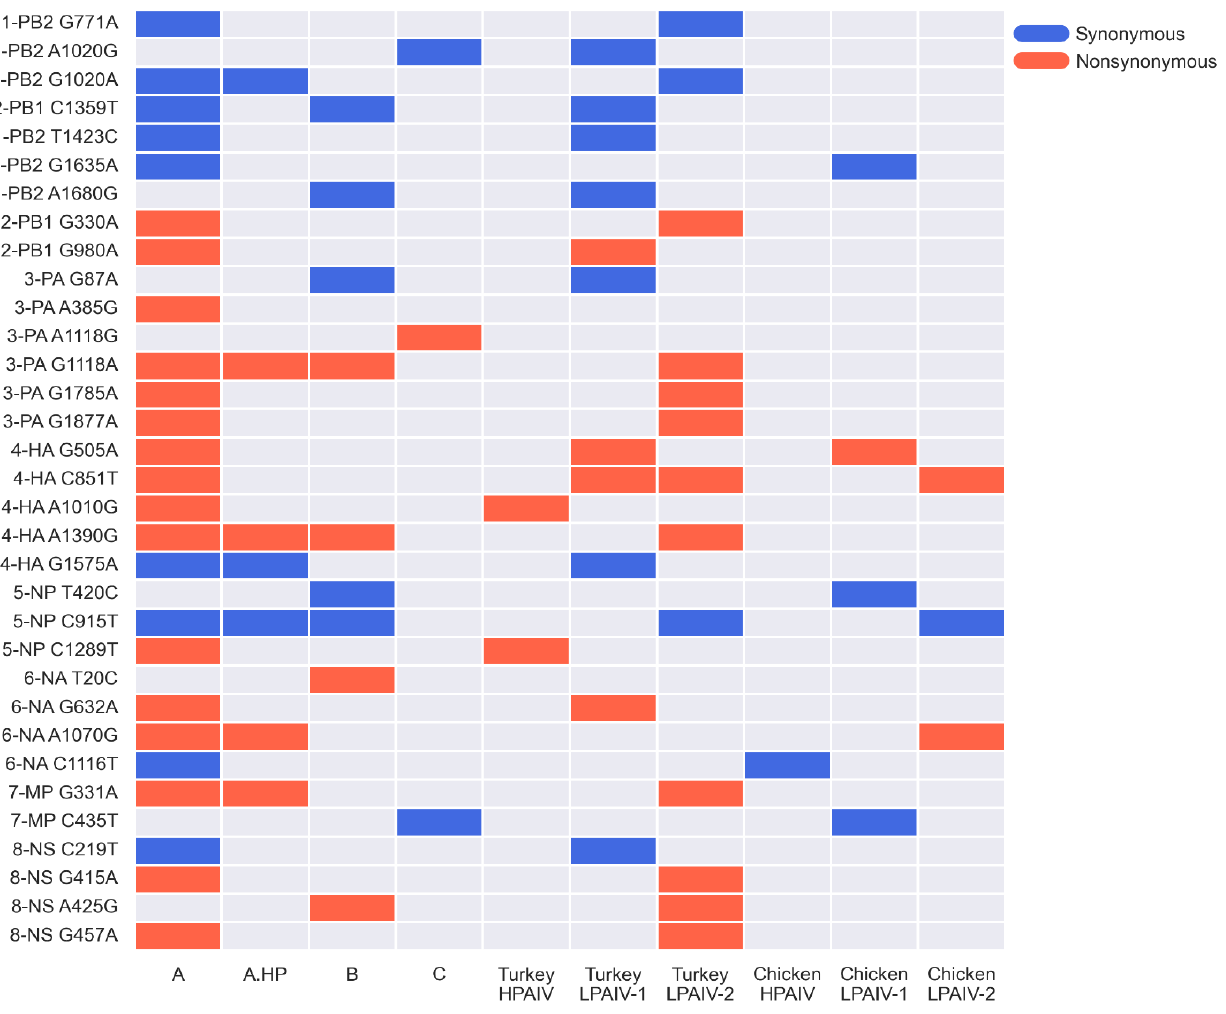
Figure 7. Matrix of common SNVs found in iSNVs, and pairwise comparisons of all H7N3 viruses sequenced from the 2020 US outbreak. The iSNVs identified in samples from experimentally infected turkeys and chickens were compared against the single nucleotide changes that were found in all possible pairwise comparisons among all twenty-nine virus isolates during the 2020 US H7N3 outbreak [30]. On the left of the matrix, the nucleotide position of the iSNV in the corresponding segment is flanked by two letters that show the nucleotide substitution from left to right. Squares in red or blue indicate the presence of the corresponding iSNV to the left of the matrix. Red squares represent nonsynonymous iSNVs, whereas blue squares represent synonymous iSNVs. Outbreak sequences were also categorized according to the phylogenetic clusters A, A. HP, B, and C identified previously [30].